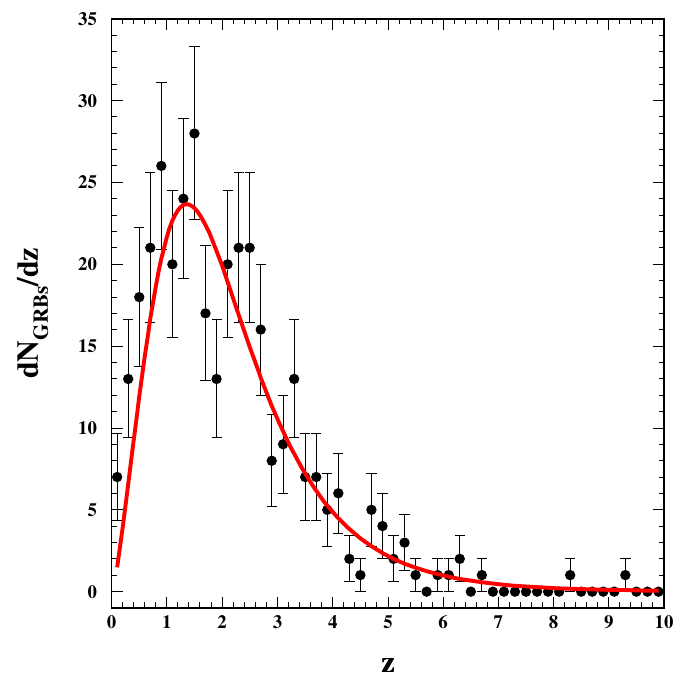
Figure 22. Comparison between the redshift distribution of 356 long GRBs with known redshift observed before June 2018 and their CB-model’s expected distribution if the production rate of GRBs is proportional to the SFR; ( χ 2 /dof = 37.57/49 =